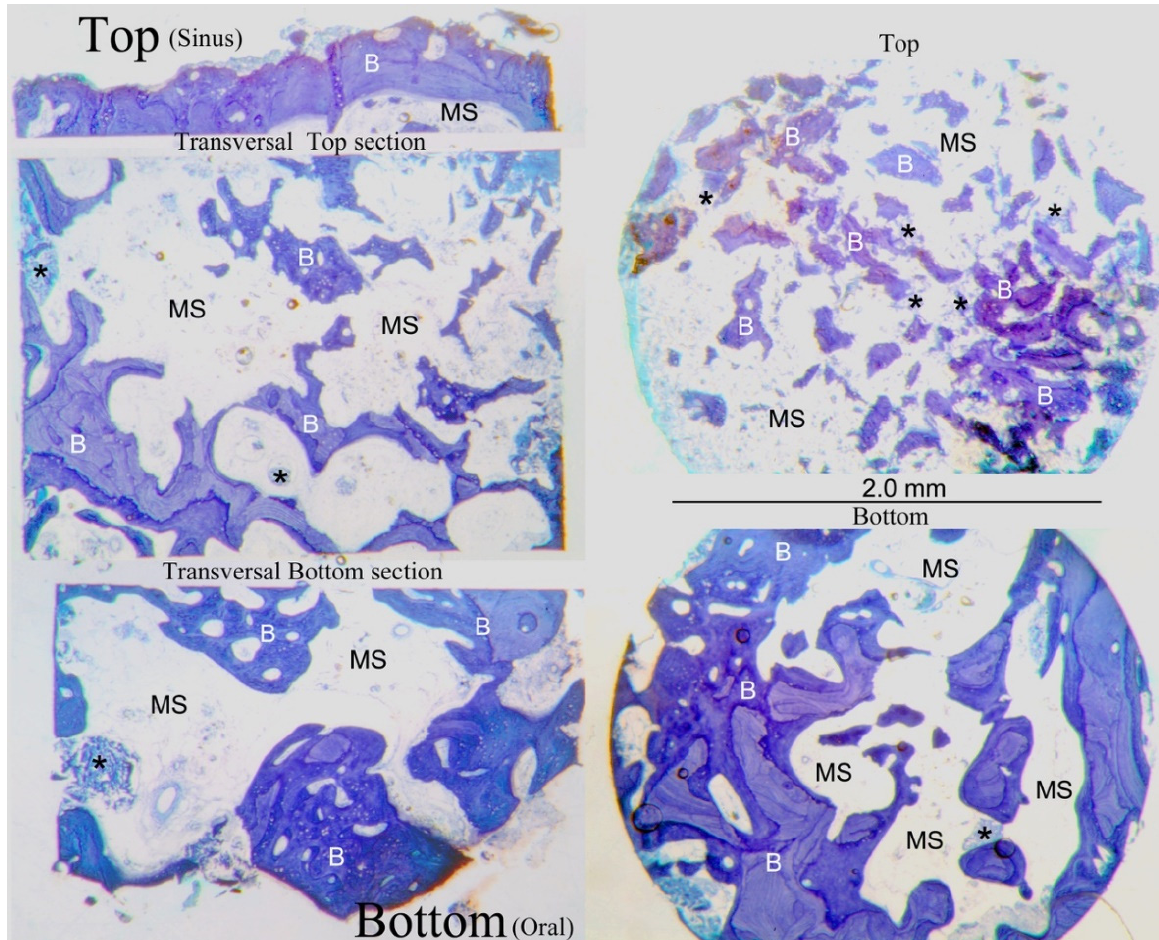
Figure 3. Low-power magnification (9×) of the bone core in the longitudinal section appeared to be well organized with a trabecular network (B) and several distributed marrow spaces (MS). No bio- material remnants were reported. (CB) crestal bone; (SB) sinus bone; azure B–methylene blue stain- ing was used.